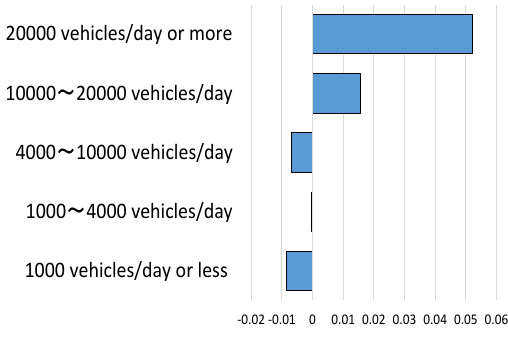
Figure 14. Daily traffic volume category scores (bearings).